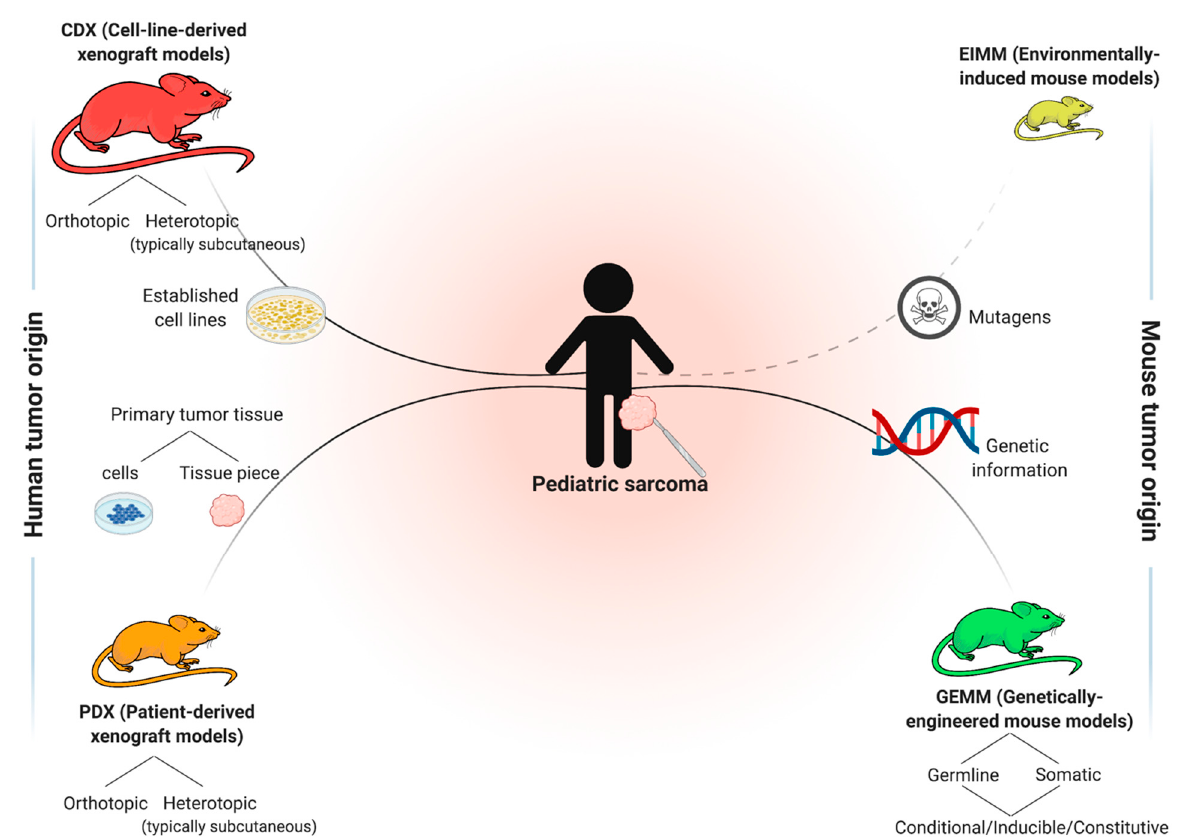
Figure 2. Different approaches to model sarcoma in vivo. Relative sizes of mouse pictograms resemble approximate utili-zation of modeling approaches in current sarcoma research. Dashed line illustrates that environmentally-induced models (EIMMs) are typically not particularly relevant for childhood sarcoma.